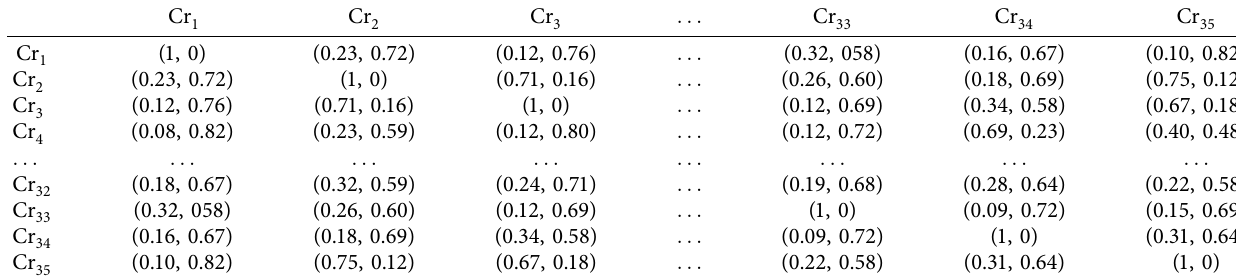
Table 3: Customer demands: evaluation